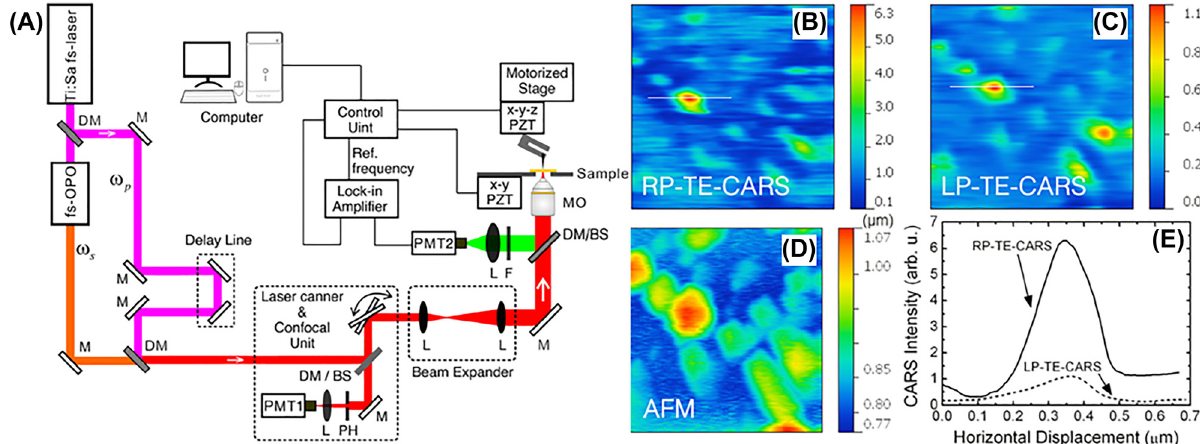
Figure 8: Coherent anti-Stokes Raman scattering microscopy illuminated via CVB. (A) Schematic of the radially polarized tip-enhanced near-field CARS microscope. DM, dichroic mirror; L, lens; M, mirror; RP, radial polarizer; MO, microscope objective; F, filter; PZT, piezoelectric transducer; PH, pinhole; BS, beam splitter; PMT, photomultiplier tube. (B) Radially polarized near-field TE-CARS images of polystyrene beads with sizes varying from 100 to 300 nm. The image size is 1.5 × 1.5 μ m 2 . (C) Linearly polarized near-field TE-CARS images of the same samples with (A). The image size is 1.5 × 1.5 μ m 2 . (D) AFM images of the same samples with (A). The image size is 1.5 × 1.5 μ m 2 . (E) Intensity profiles along the white lines in (B) and (C). Adapted from Ref. [153]. Copyright 2013 AIP Publishing